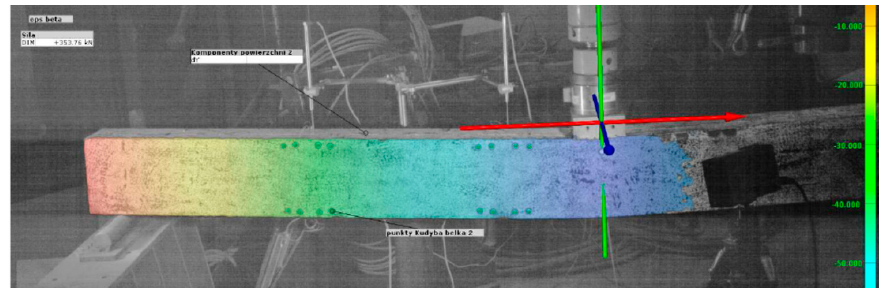
Figure 5. An exemplary map of vertical displacements of the analyzed beam.